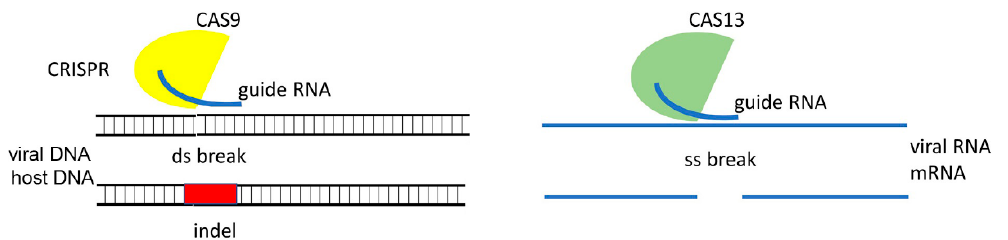
Figure 4. Schematic representation of the CRISPR-Cas technology. The Cas9 endonuclease in a complex with a sgRNA binds to the DNA target site and mediates a double-strand break which is then repaired, inducing deletions or insertions (gene knock-out). Cas13 in conjunction with sgRNA binds to the target RNA site and cleaves the RNA molecule.